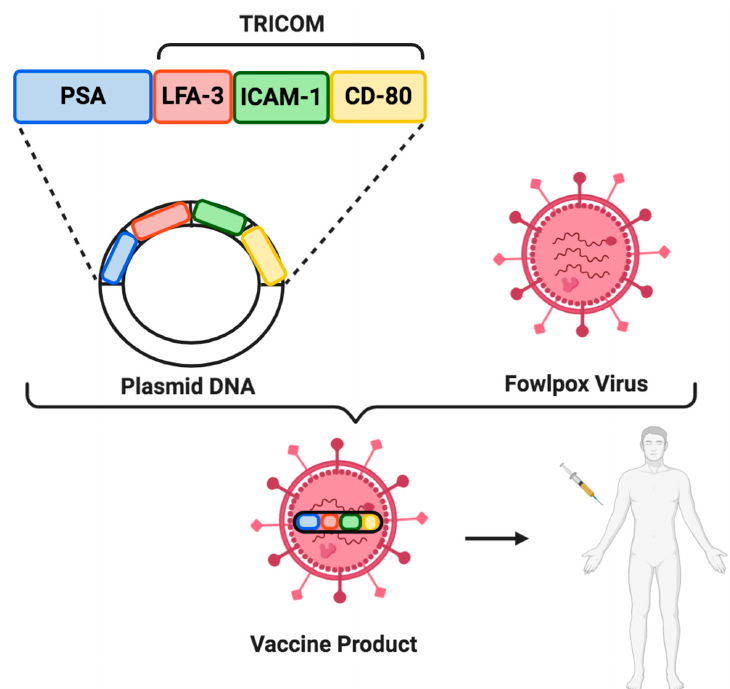
Figure 2. PROSTVAC-VF vaccine. PROSTVAC-VF consists of a recombinant vaccinia vector followed by multiple booster vaccination using a recombinant fowlpox vector. Both vectors contain PSA and the TRIad of CO-stimulatory Molecules (TRICOM), which in turn includes B7-1, ICAM-1, and LFA- 3. Another cancer vaccine, GVAX, consists in genetically modified tumor cells able to secrete GM- CSF, with a mechanism of action based on the use of two prostate cell lines, LN-CaP (hormone- sensitive cancer cell lines deriving from nodal site of metastasis) and PC-3 (hormone-refractory cancer cell lines deriving from bone metastases) [86]. Despite early evidence supported the use of GVAX in hormone-naïve PCs, the phase III VITAL-1 and VITAL-2 trials showed disappointing results [87,88]. More specifically, the randomized, open-label VITAL-2 trial comparing GVAX plus docetaxel versus docetaxel alone in taxane-naïve mCRPC, was closed prematurely given an increased mortality rate